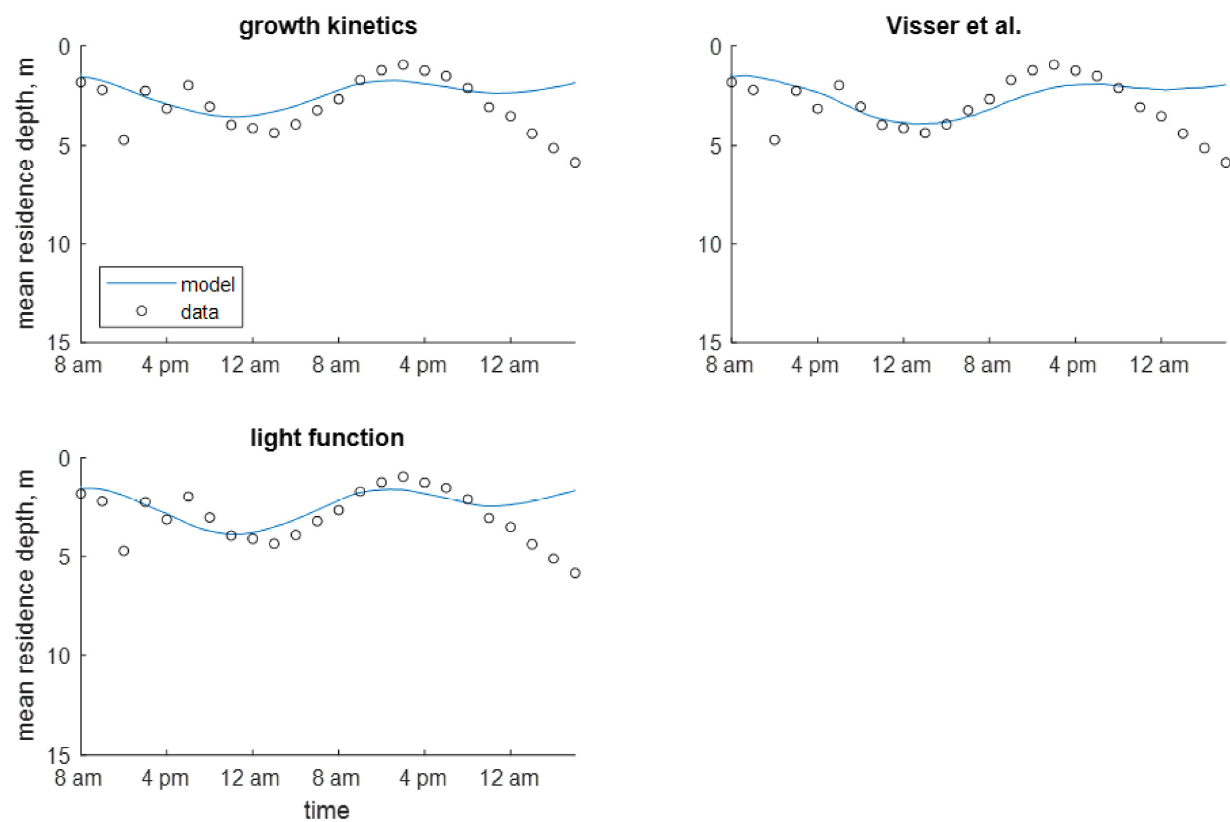
Figure 6. Time series of observed and predicted mean residence depth of chlorophyll a concentration in the Shennong Stream open water site using dynamic velocity models (particle-tracking)